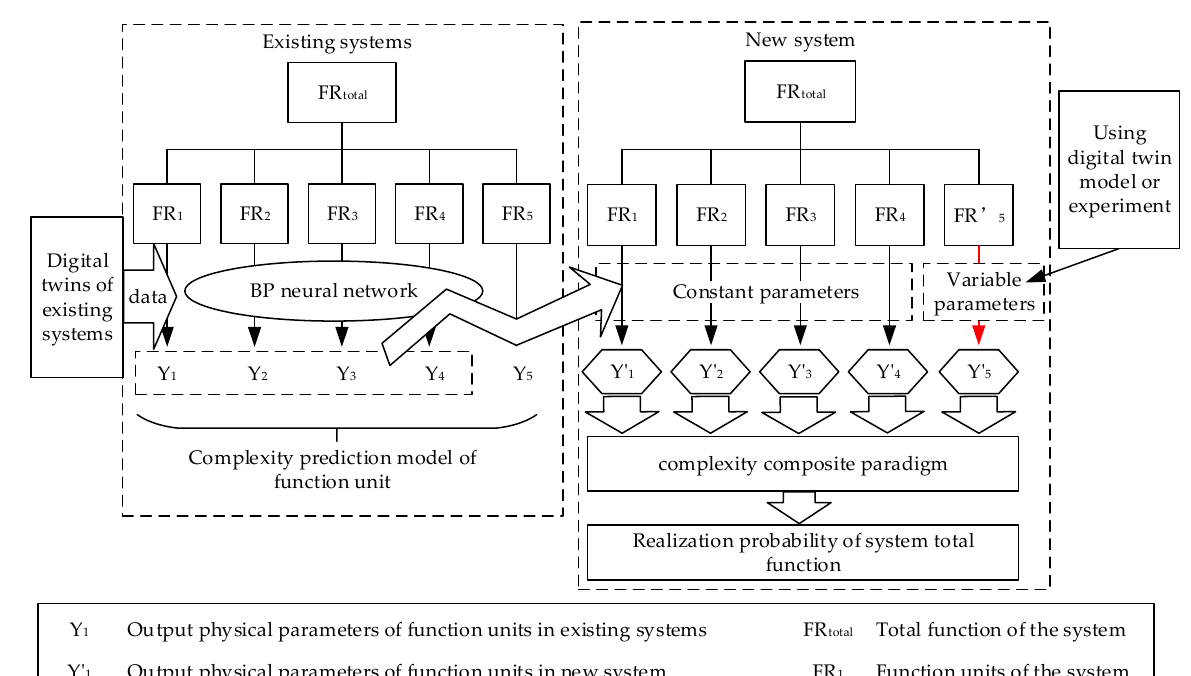
Figure 3. Complexity composite process.